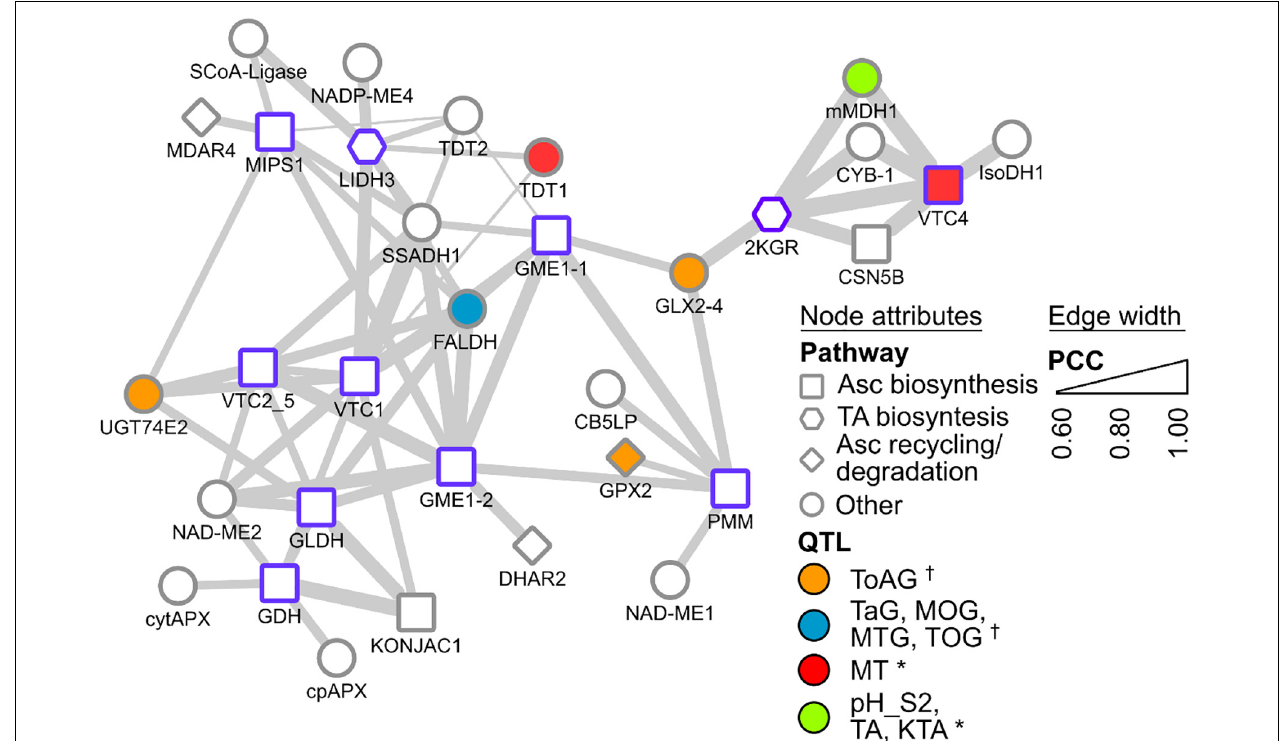
FIGURE 3 | Gene co-expression subnetwork of selected Asc and TA biosynthesis genes. Genes are depicted as nodes and edges depict Pearson correlation coefficients (PCCs) between nodes. Node borders in purple indicate query gene. Node shapes indicate their annotated functional categories. Node color indicate association with known berry acidity QTLs [e.g., † , Houel et al. (2015); *, Duchêne et al. (2020)]. Edge width indicates increasing PCC. Gene abbreviations are SCoA-Ligase succinyl CoA ligase, NADP-ME NADP-dependent malic enzyme, MDAR monodehydroascorbate reductase, MIPS myo -inositol-3-phosphate synthase, L-IDH L-idonate dehydrogenase, SSADH succinate semialdehyde dehydrogenase, TDT tonoplast dicarboxylate transporter, GME GDP-D-mannose epimerase, FALDH glutathione-dependent formaldehyde dehydrogenase, VTC1 GDP-D-mannose pyrophosphorylase, VTC2_5 GDP-galactose phosphorylase, NAD-ME NAD-dependent malic enzyme, GLDH L-galactono-1,4-lactone dehydrogenase, GDH L-galactose dehydrogenase, cytAPX cytosolic ascorbate peroxidase, cpAPX chloroplastic ascorbate peroxidase, DHAR dehydroascorbate reductase, UGT74E2 UDP-glucosyltransferase, KONJAC a sugar pyrophosphorylase that can stimulate VTC1 activity, GLX glyoxylase, GPX glutathione peroxidase, CB5LP a cytochrome B5, PMM phosphomannomutase, 2KGR 2-ketogulonic acid reductase, mMDH mitochondrial malate dehydrogenase, CYB Cytochrome B561, CSN5B interacts and modulates activity of VTC1, VTC4 L-galactose-1-phosphate phosphatase, IsoDH isocitrate dehydrogenase. Relevant QTLs from Houel et al. (2015) include: ToAG, total acids at green lag phase; TaG: tartrate at green lag phase; MOG: malate/total acids ratio at green lag phase; MTG, malate/tartrate ratio at green lag phase; and TOG, tartrate/total acids ratio at green lag